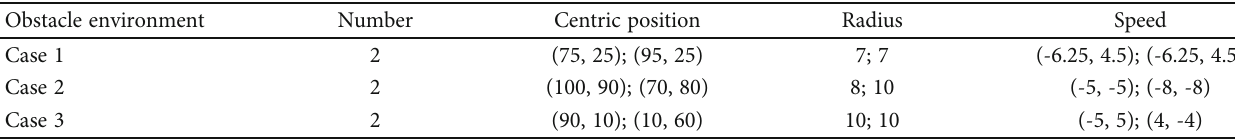
Algorithm 1: Receding horizon control with extended solution. Table 1: Dynamic obstacle environment.